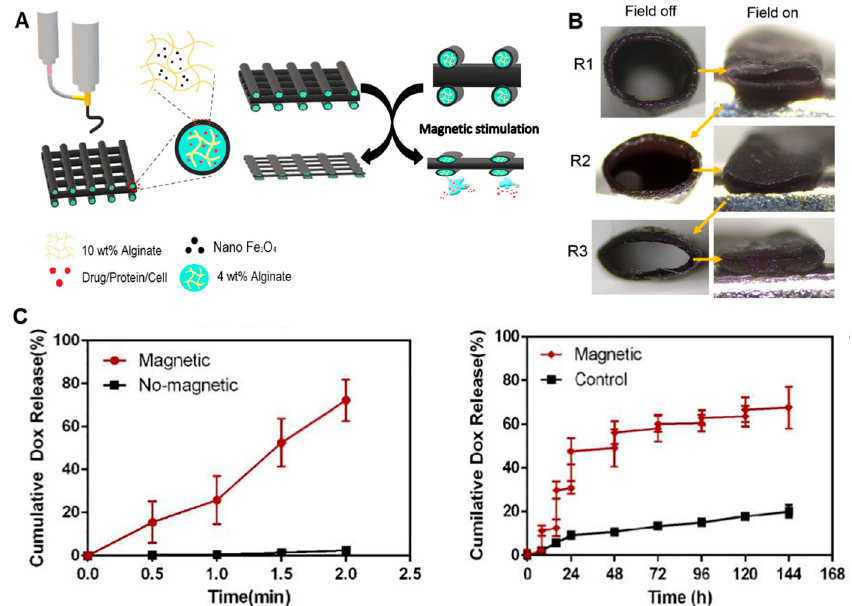
Figure 14. ( A ) Scheme of 3D printing magnetically driven drug delivery system. Under magnetic stimulation the drug-loaded core was extruded from the open ends of the scaffolds achieving drug release. ( B ) The images of the hollow alginate/iron oxide nanoparticle scaffold under magnetic field off/on for three cycles. ( C ) Cumulative doxorubicin release from the scaffold under the magnetic stimulation. Left: for 2 min. Right: over 144 h and under repeated magnetic field on/off. Reprinted with permission from [187], Copyright 2020, Elsevier.